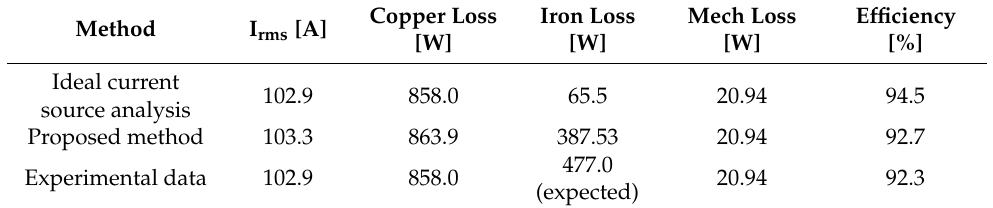
Table 5. Case 2: 155 Nm at 1000